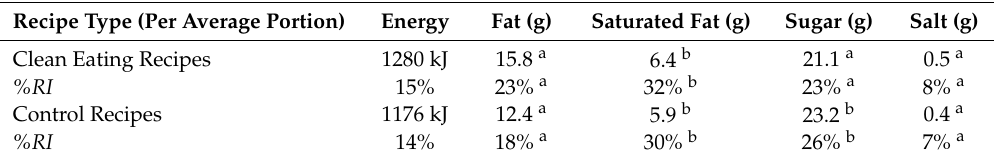
Table 5. Mock Traffic Light Label using FSA criteria for average nutrient values of recipes according to their clean or control